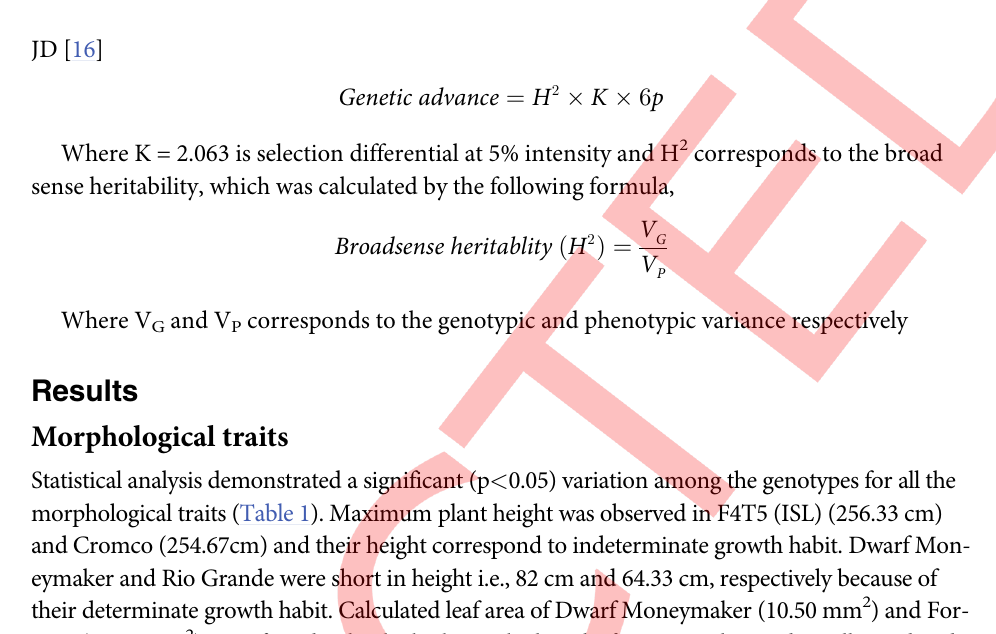
eymaker and Rio Grande were short in height i.e., 82 cm and 64.33 cm, respectively because of